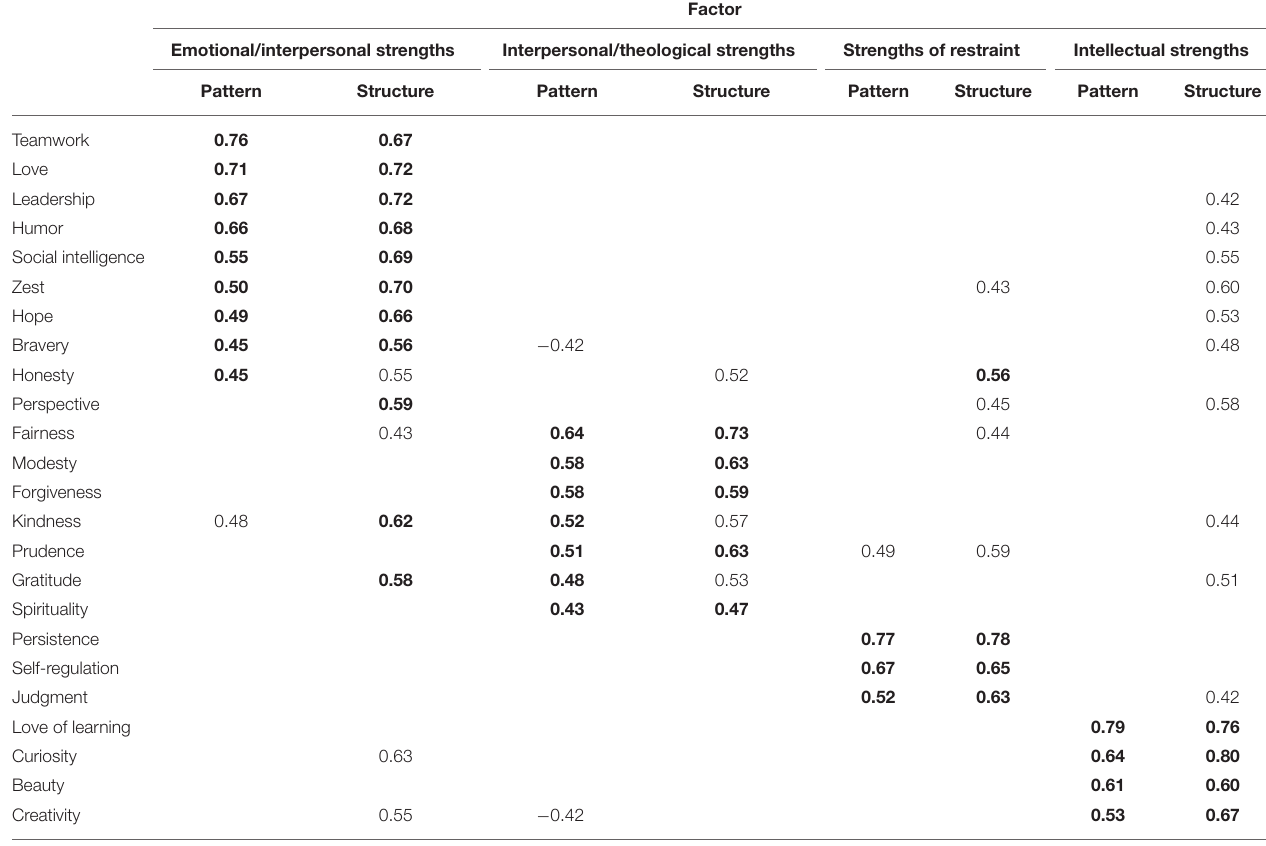
TABLE 3 | The four-factor structure of the character strength scale from the IPIP-VIA questionnaire in poland ( N = 908). Factor Emotional/interpersonal strengths Interpersonal/theological strengths Strengths of restraint Intellectual strengths Pattern Structure Pattern Structure Pattern Structure Pattern